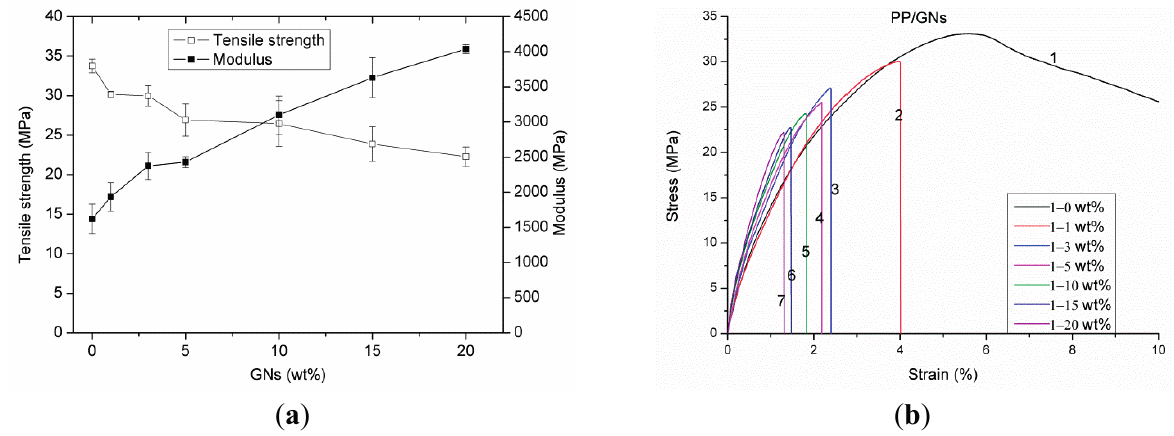
Figure 5. The tensile properties of PP/GNs composites: ( a ) tensile strength and modulus and ( b ) stress-strain curve.